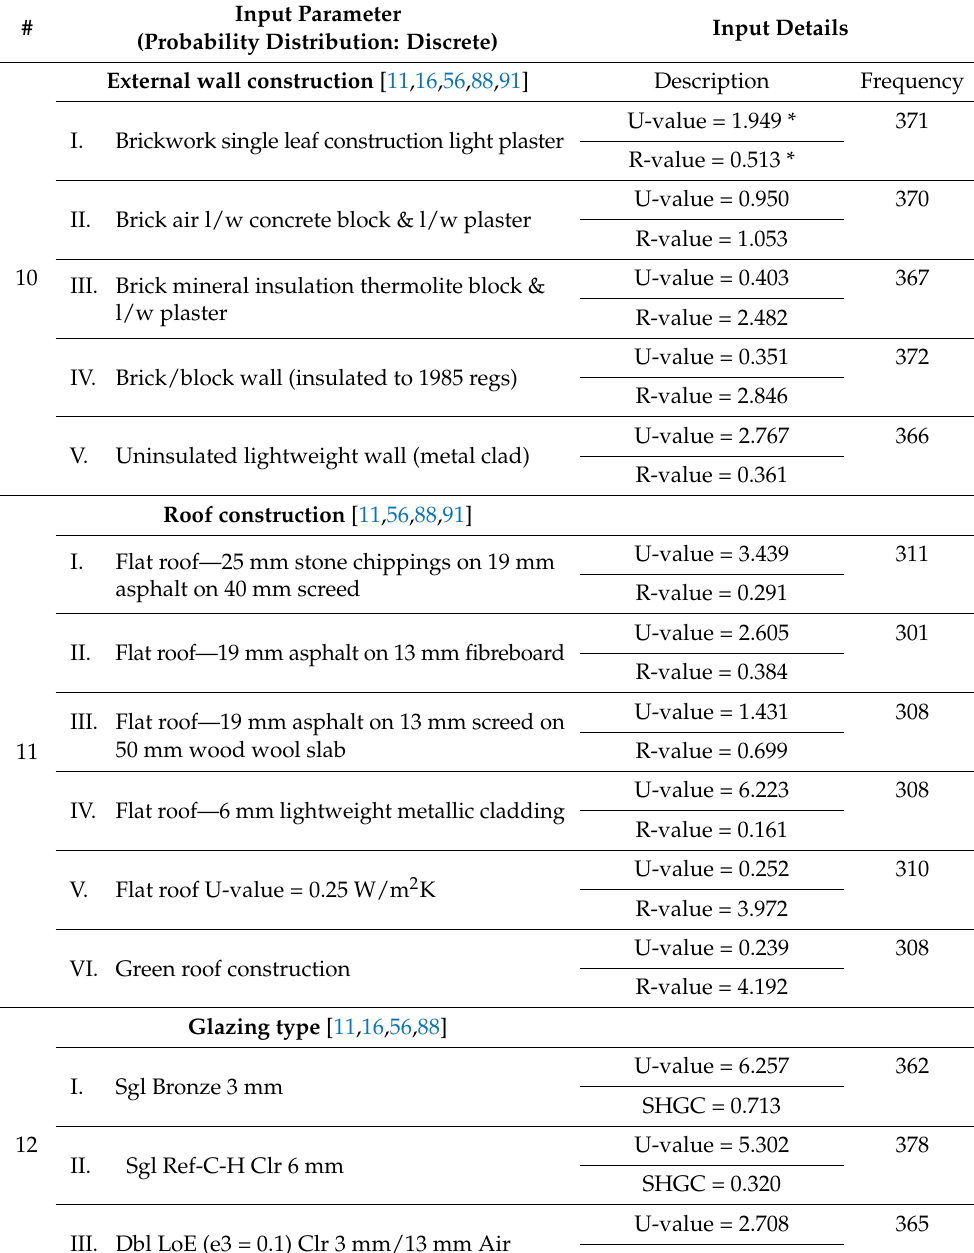
Table 2. Statistical output and distribution profiles for discrete distribution characteristics of input